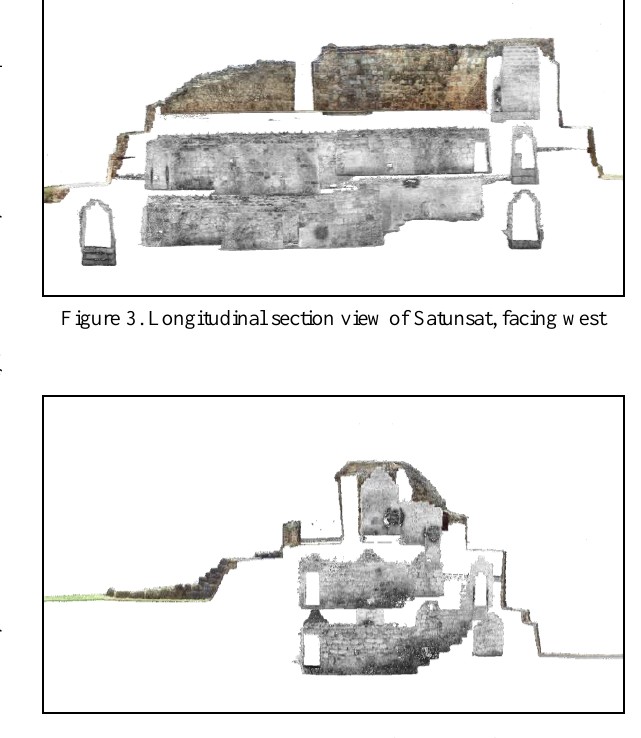
Figure 4. Transverse section view of Satunsat, facing